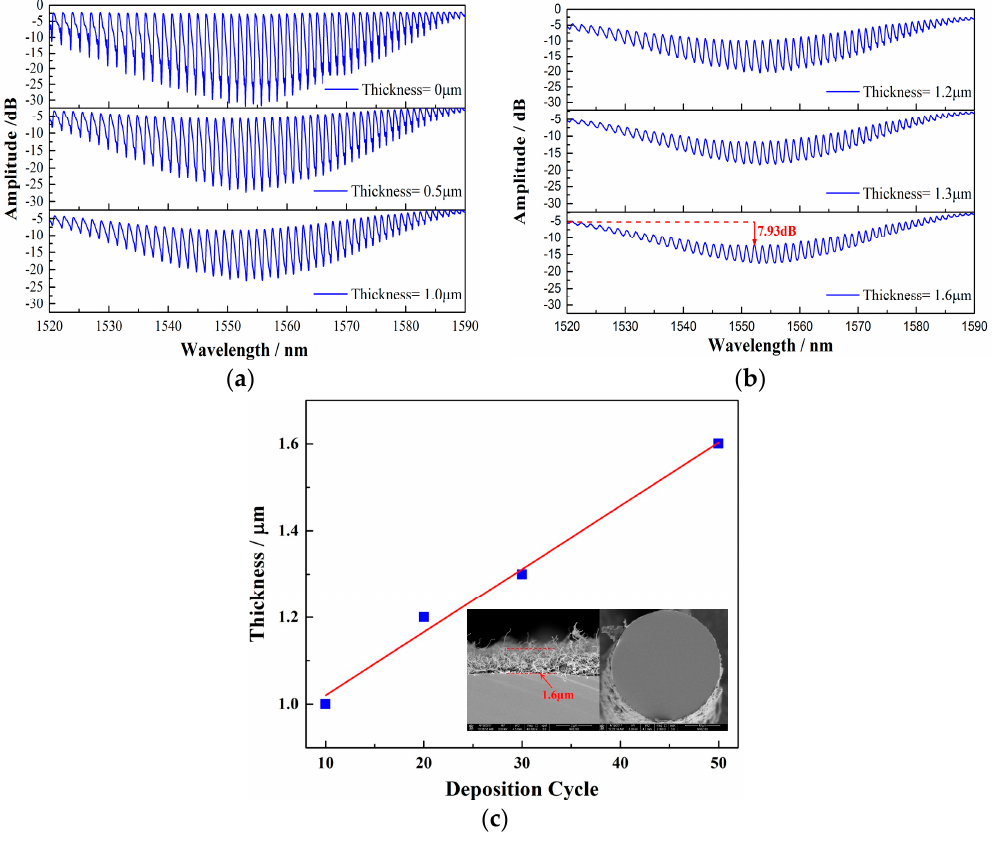
Figure7. ( a , b ) The transmission spectrum of a 12° TFBG with different SWCNT film thicknesses. The depth of the upper envelope of the cladding modes are 0 dB, 1.001 dB, 5.312 dB, 6.758 dB, 7.372 dB, and 7.93 dB, respectively. ( c ) The SWCNT film thickness with respect to the deposition cycle.